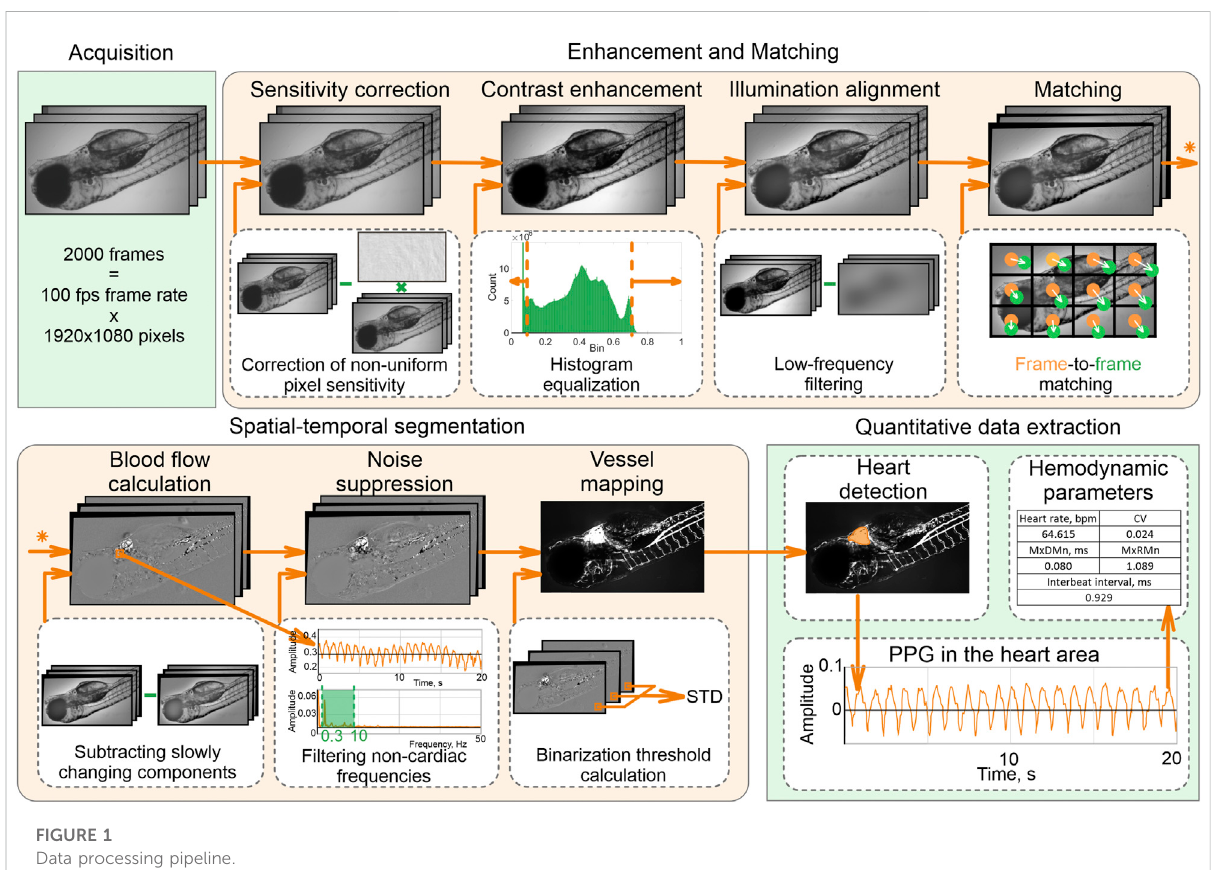
FIGURE 1 Data processing